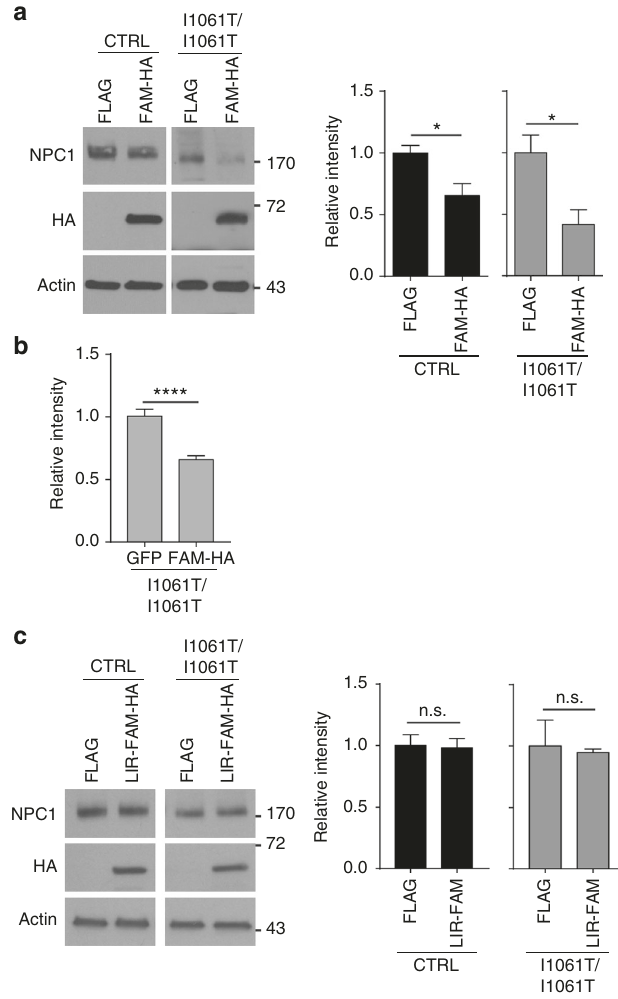
Fig. 6 FAM134B over-expression enhances degradation of I1061T NPC1. a , b Over-expression of FLAG (control vector) or FAM134B-HA (FAM-HA) in CTRL and I1061T NPC1 fi broblasts. NPC1 protein levels were quanti fi ed by a western blot and b confocal microscopy. c Over-expression of FLAG (control vector) or FAM134B lacking the LC3 interacting domain (LIR-FAM- HA) in CTRL and I1061T NPC1 fi broblasts. NPC1 was analyzed by western blot. Quanti fi ed at right. Data are mean ± s.e.m. a N = 3 – 6 and c N = 3 independent experiments, b >32 cells per group. a – c Student ’ s t -test; a (CTRL) t = 3.092, (I10) t = 3.113; b (I10) t = 5.511. n.s., not signi fi